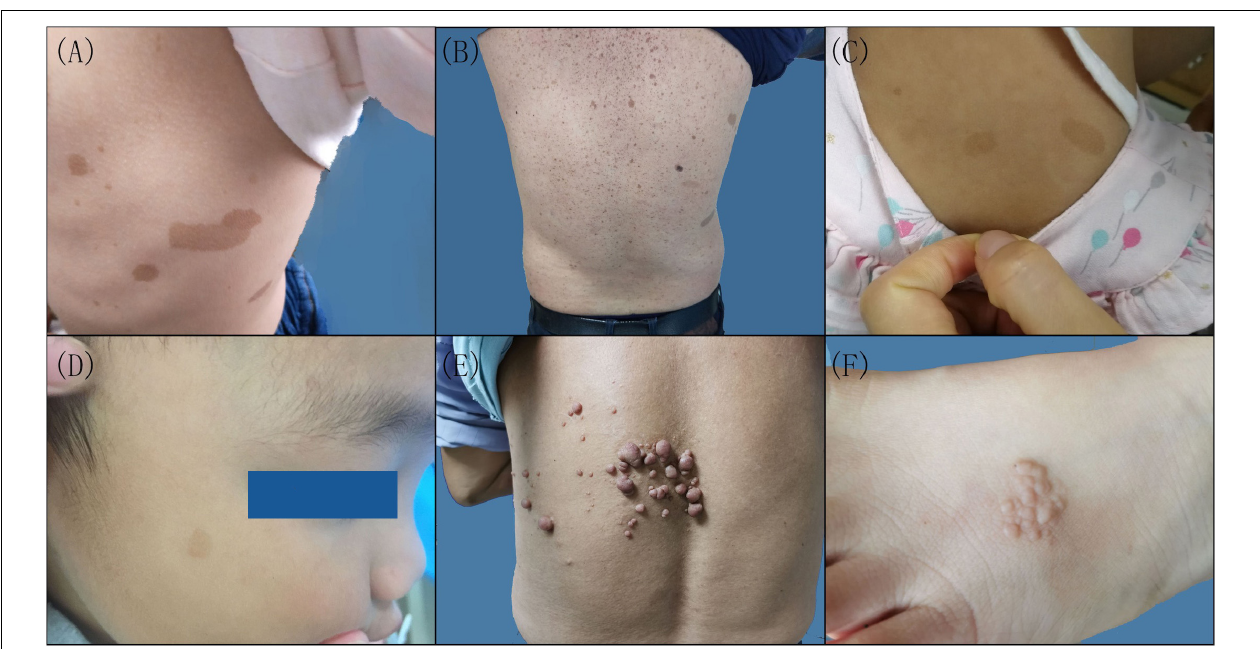
FIGURE 1 | Clinical features of the patients with neurofibromatosis (NF). Multiple cafeÌ-au-lait macules were scattered on the left lateral chest of the proband (A) and the back of the proband’s father in family 1 (B) , the back of the proband in family 2 (C) , and the right side of the face of the proband in family 3 (D) . (E) Cutaneous neurofibroma on the back of the proband in family 4. (F) Skin pigmented plaques on the left foot back of the proband in family 5. TABLE 1 | Clinical characteristics of the neurofibromatosis proband study. Family